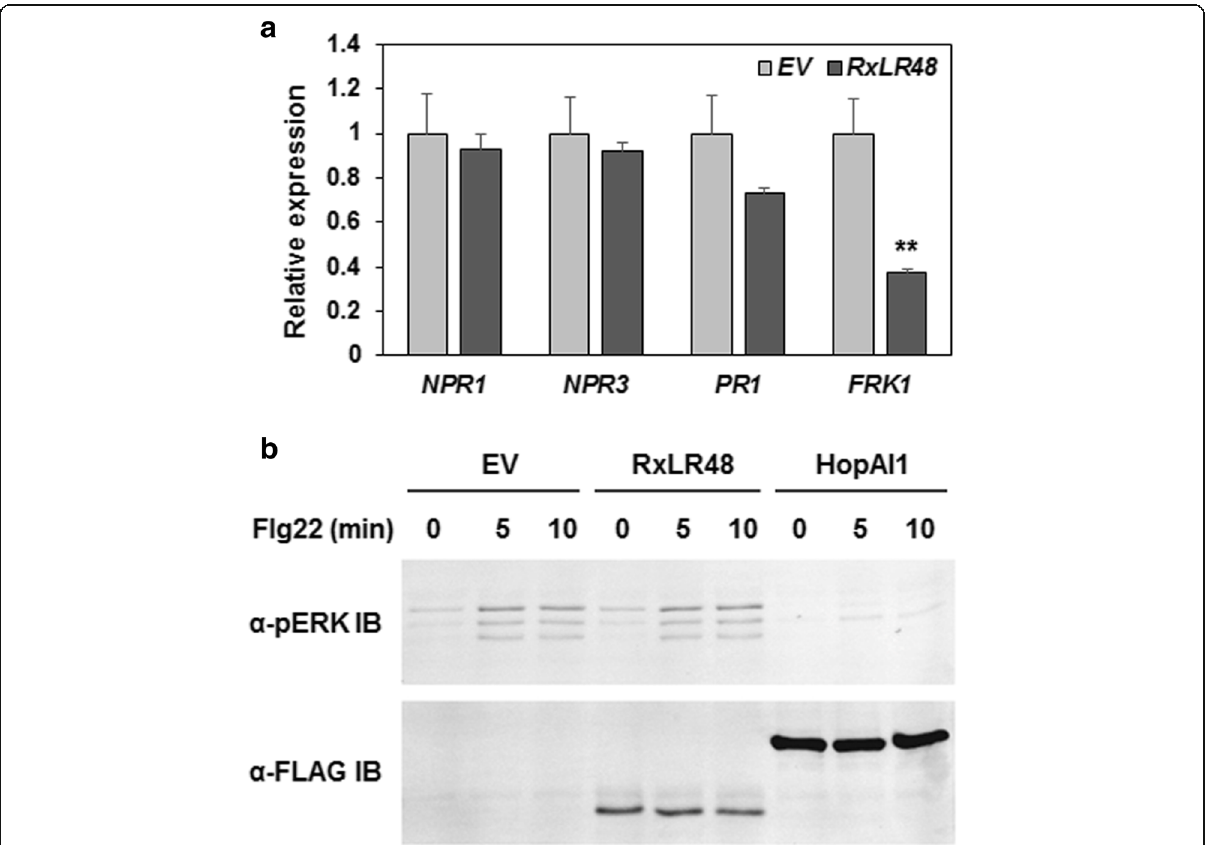
Fig. 7 RxLR48 down-regulates expression of FRK1. a Transcription levels of NPR1 -related genes and FRK1 . Protoplasts were transiently transfected with the indicated constructs. For detection of NPR1 , NPR3 and PR1 gene expression, protoplasts were harvested directly after incubation; For FRK1 detection, protoplasts were treated with 1 μ M flg22 for 8 h before harvest. Real-time RT-PCR were carried out to analyze relative expression of the genes in Arabidopsis with the actin gene as a reference. Each data represents the mean of three replicates. Error bars indicate standard deviation. Asterisks indicate significant differences (**, P < 0.01, Student ’ s t test). b Flg22-induced MAPK activation. Protoplasts were transfected with empty vector, RxLR48 and HopAI1 (positive control), and treated with 1 μ M flg22 at the indicated time points before protein extraction. Total proteins were analyzed by immunoblot with Phospho-p44/42 MAPK antibody ( α